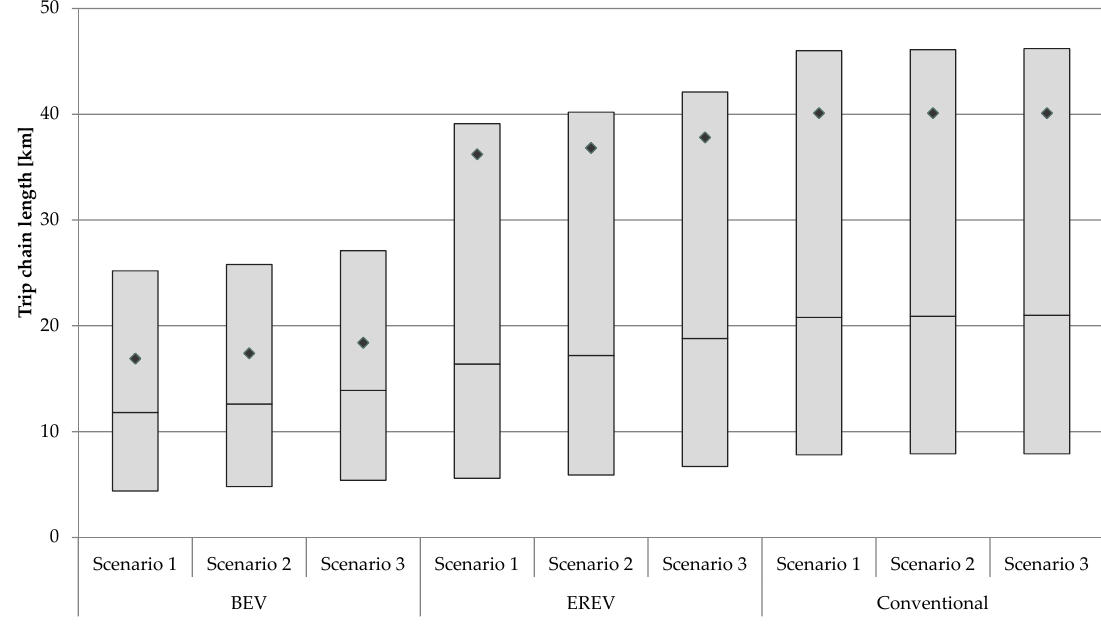
Figure 2. Distribution of car trip chains, differentiated by scenario and propulsion system (mean (diamond), median (line), upper and lower quartile (box))